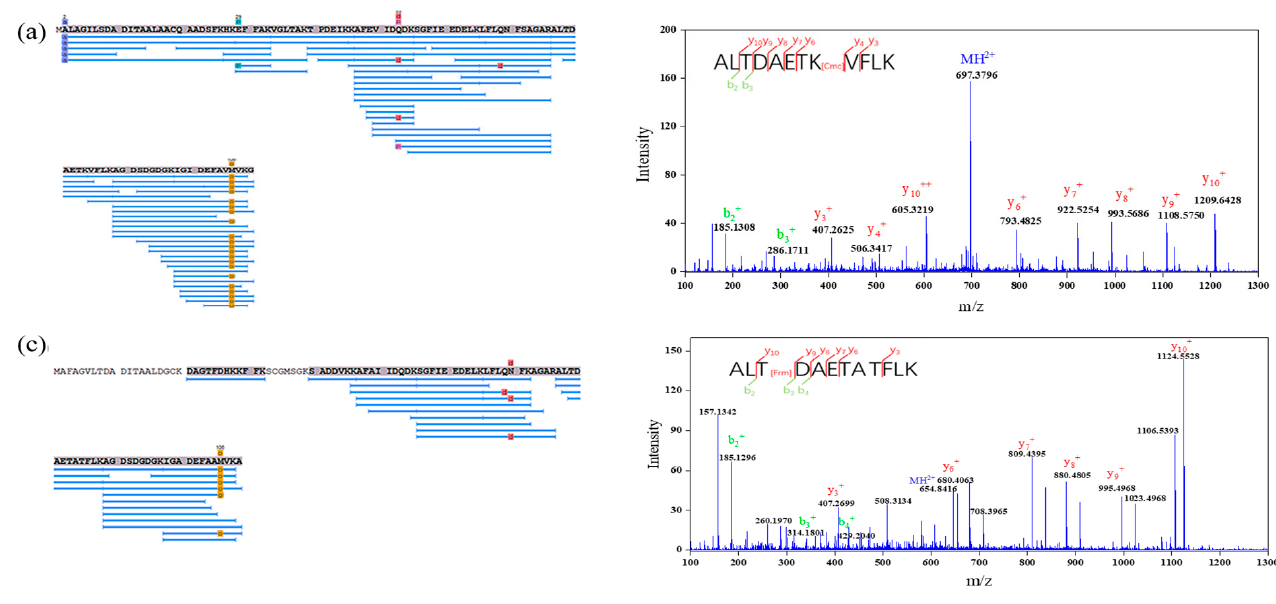
Figure 1. SDS-PAGE analysis of parvalbumin samples obtained during the Maillard reactions. ( a ) SDS-PAGE of parvalbumin from orthogonal experiments; M: MW Markers; G1 (Glucose, 0.5 mol/L, 5 min), G2 (Glucose, 1.0 mol/L, 10 min), G3 (Glucose, 1.5 mol/L, 15 min), M1 (Maltose, 0.5 mol/L, 10 min), M2 (Maltose, 1 mol/L, 15 min), M3 (Maltose, 1.5 mol/L, 5 min), S1 (Sucrose, 0.5 mol/L, 15 min), S2 (Sucrose, 1.0 mol/L, 5 min) and S3 (Sucrose, 1.5 mol/L, 10 min) were heated by a microwave; ( b ) SDS-PAGE analysis on native parvalbumin and glycated parvalbumin heated by a microwave or an induction cooker. N: native (unmodified and unheated) parvalbumin; G-Heating (Glucose, 1.5 mol/L, 15 min), M-Heating (Maltose, 1.5 mol/L, 15 min) and S-Heating (Sucrose, 1.5 mol/L, 15 min) were heated by an induction cooker.